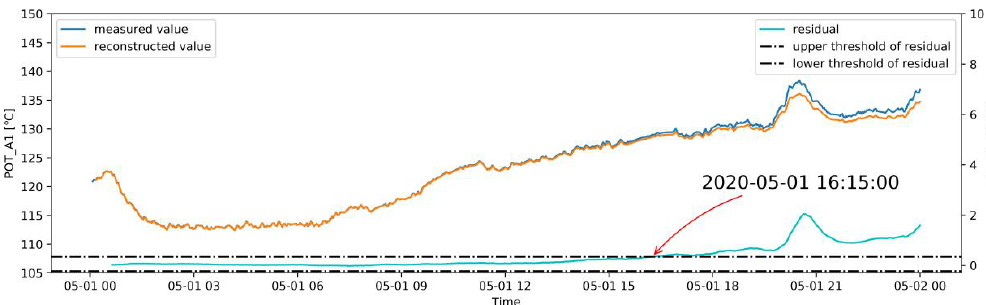
Figure 17. Real-time monitoring of POT_A1 in an abnormal case.